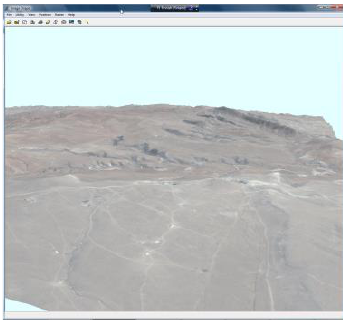
Figure 18. 3D-landscape model of pastoral steppe on Jebel Bishri constructed by fusing QuickBird imagery with ASTER-DEM data. Constructed by M. Törmä